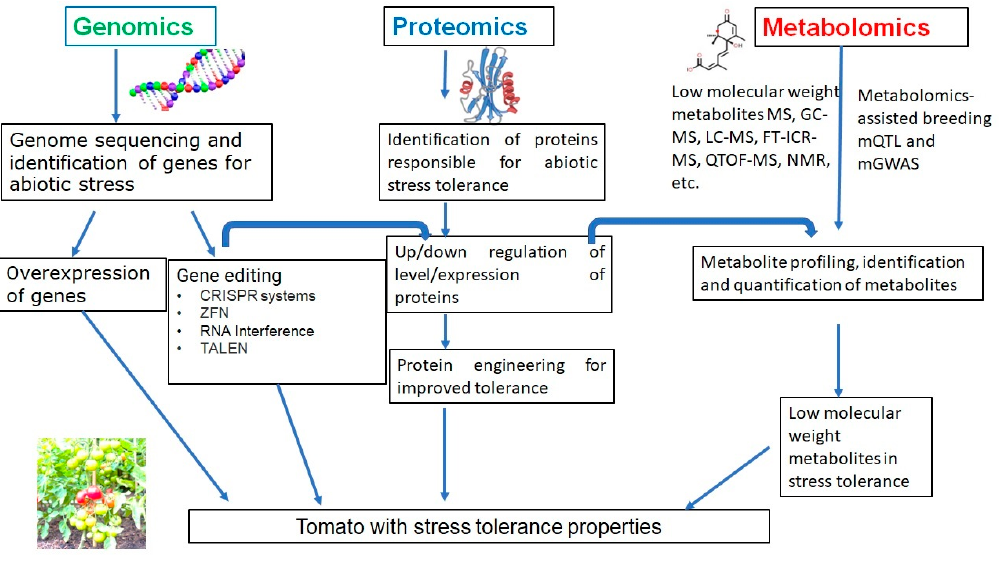
Figure 3. The framework of study techniques for the studies of genomics, proteomics, and metabo- lomics for tomato.